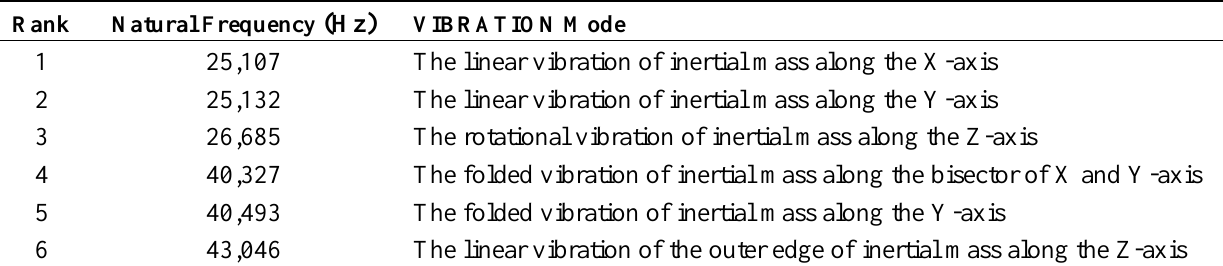
Table 3. Simulation results of modal analysis.